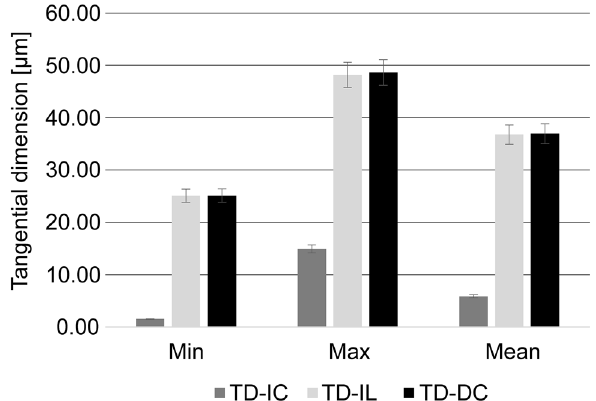
Figure 5. Diagram showing a comparison of the minimal (Min) and maximal (Max) values obtained, as well as mean values calculated for the dimensions measured, i.e. tangential dimension of an intrusively growing initial (TD-IC), tangential dimension of two radial files adjacent to intrusively growing initial together with tangential dimension of growing initial—measured in initial layer (TD-IL), and tangential dimension of the same two radial files distanced from initial layer (TD-DC) in Robinia pseudoacacia . Standard error bars (5%) are included. The diagram was based on data presented in Table 1. Adobe Photoshop CS6 Extended ver.13.0 × 64 (https:// www. adobe. com), and CorelDRAW Graphics Suite SE ver. 18.2.0.840 (https:// www. corel draw. com) were used.